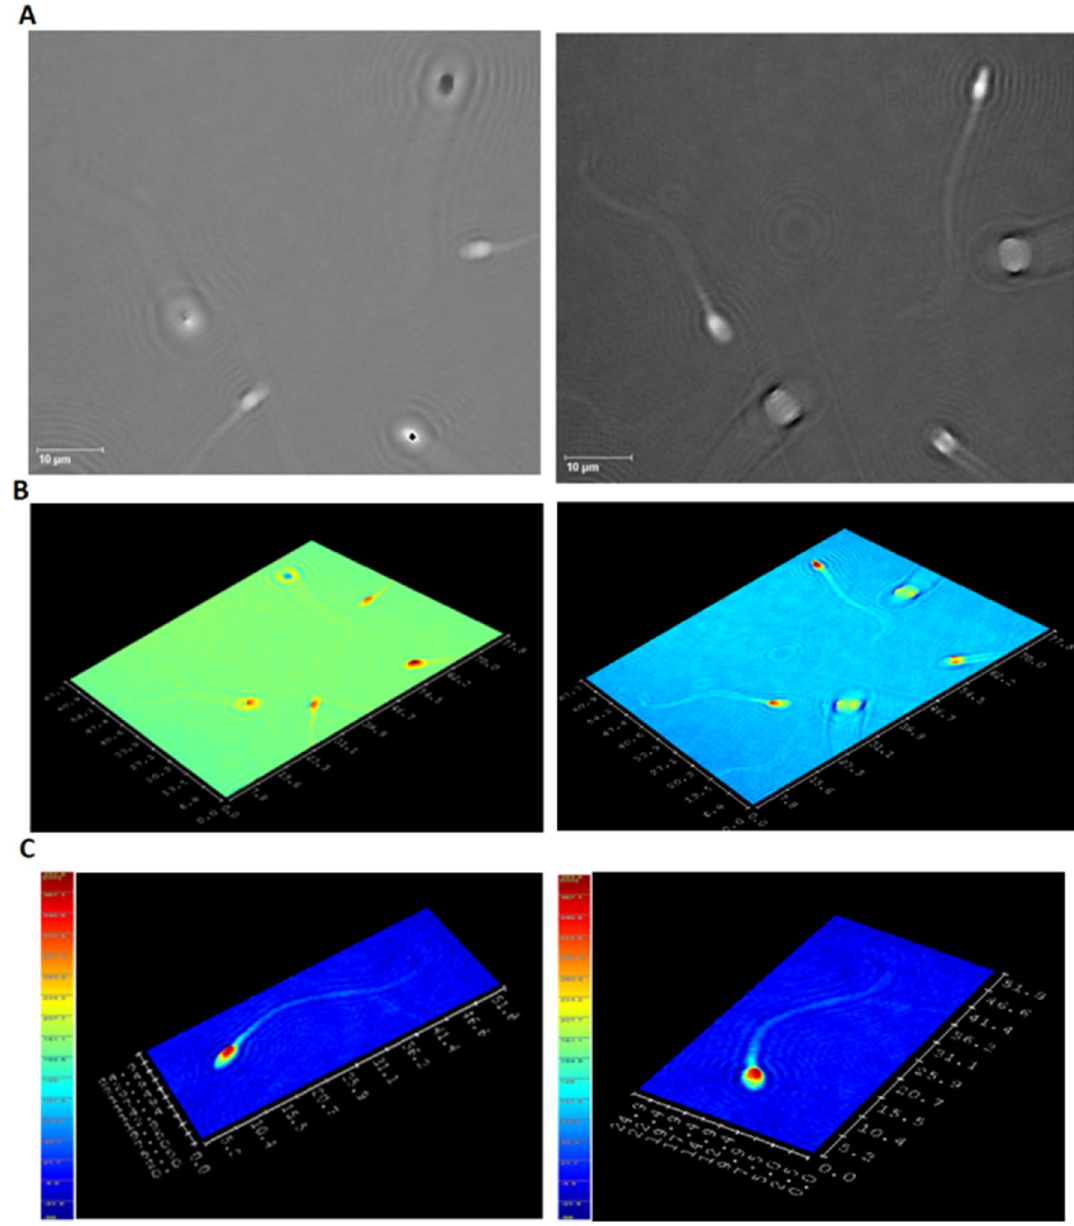
Figure 3. Holographic imaging of spermatozoa obtained via DHM. ( A ) Two phase images based on one hologram with sharpness at different sample depths. ( B ) Two computerized 3D reconstructions based on one hologram with sharpness at different sample depths. ( C ) 3D reconstructions of a single